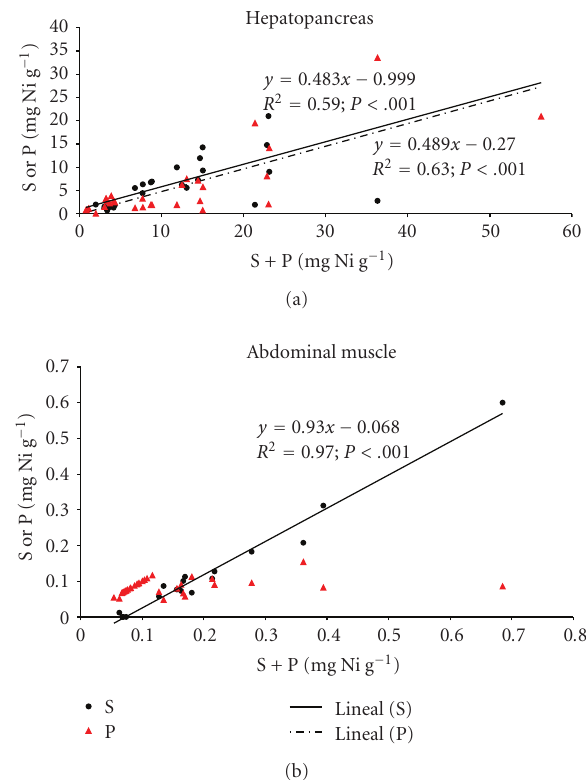
Figure 1: Relationship between soluble (S) or insoluble (P) fraction against total Ni (S+P) in the hepatopancreas and abdominal muscle of juveniles of Penaeus vannamei ( n = 31) after 10 days of exposure to 55.5 mg Ni L − 1 and 191mg Pb L − 1 or both in a mixture (MM) at 25 ◦ C and 15 ups,